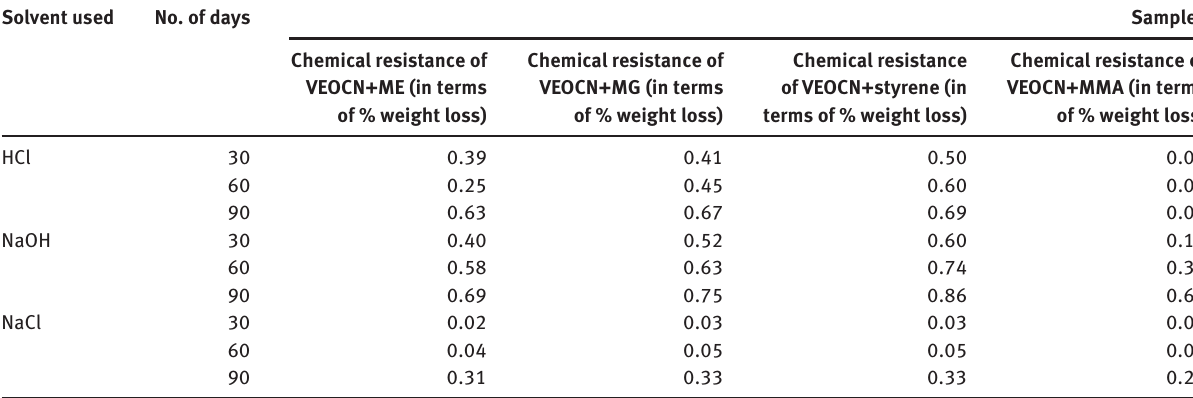
Table 4: Chemical and corrosion resistance of VEOCN samples containing styrene, MMA, MG and ME. Solvent